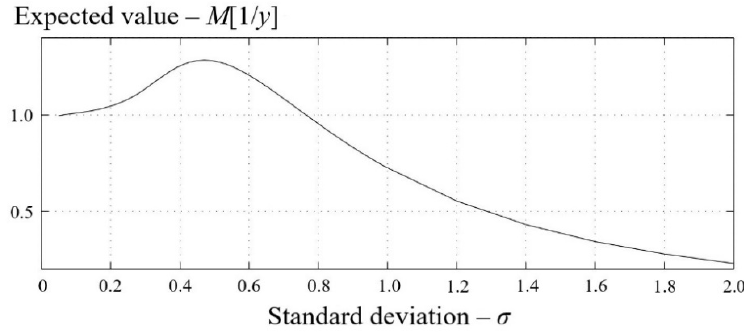
Figure 2. The dependency of the expected value of the quantity (1/ y ) on σ .